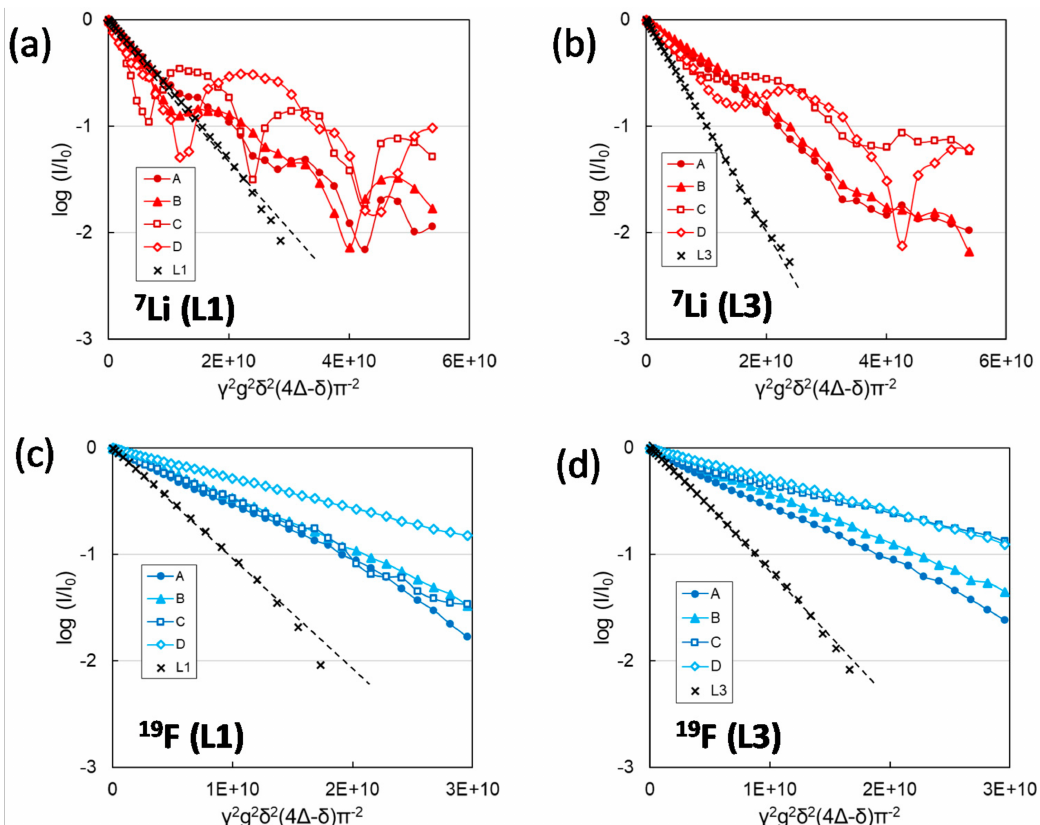
Figure 20. Comparison of the 7 Li ( a , b ) and 19 F ( c , d ) echo attenuations of L1 ( a , c ) and L3 ( b , d ) solutions in PE membranes at different stretching ratios of MD to TD used to prepare the porous membranes. A = 4.5:5.0, B = 4.5:9.0, C = 9.0:5.0. The black symbols ( × ) and dashed lines represent the echo decay of free electrolyte solutions, L1 and L3. Reprinted with permission from [51]. Copyright 2020 ACS